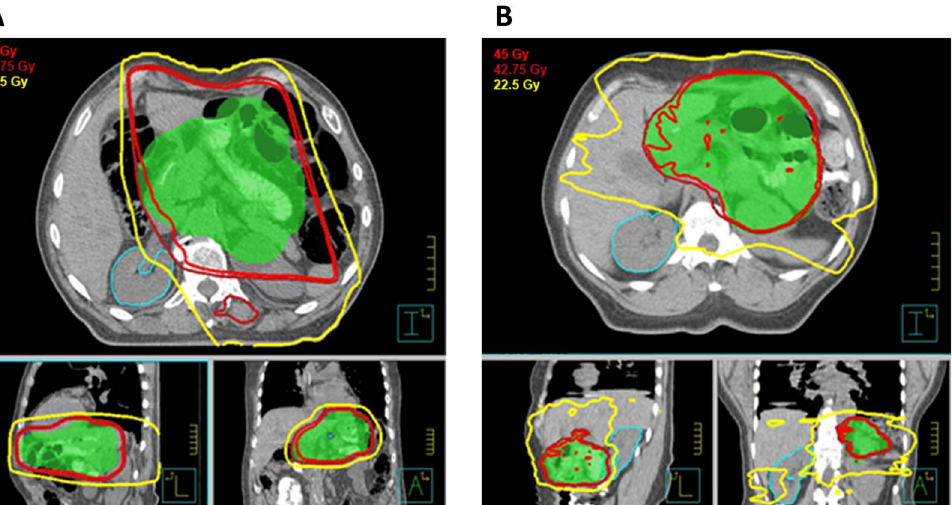
Figure 3. A. 79 year-old gentleman with gastric adenocarcinoma, T1N1M0, who underwent subtotal gastrectomy with D2 nodal dissection and adjuvant chemoradiotherapy with 3DCRT to a dose of 45 Gy. Figure 3B. 64 year-old woman with gastric adenocarcinoma, T2bN2M0, who underwent gastrectomy with D2 nodal dissection. Ten of 14 nodes were positive and she had positive proximal and distal surgical margins. She then received adjuvant chemoradiotherapy with IMRT to a dose of 45 Gy, with a 5.4 Gy boost to the